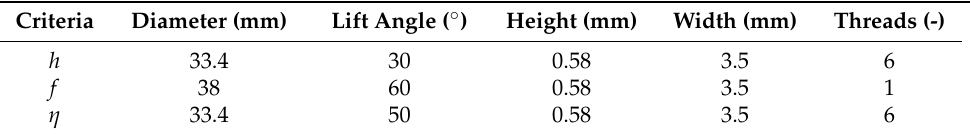
Table 3. The best rib structure at different performance evaluating